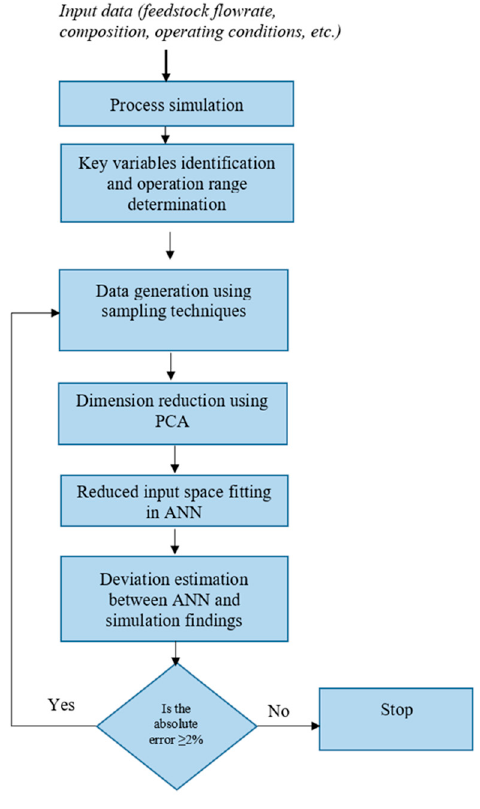
Figure 2. Adapted overall methodology.